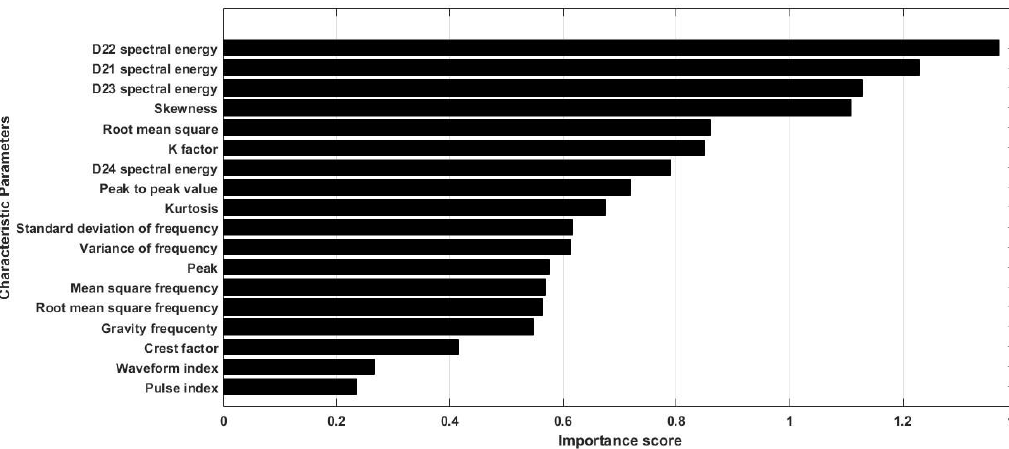
Figure 9. Importance score’s ranking of variables.